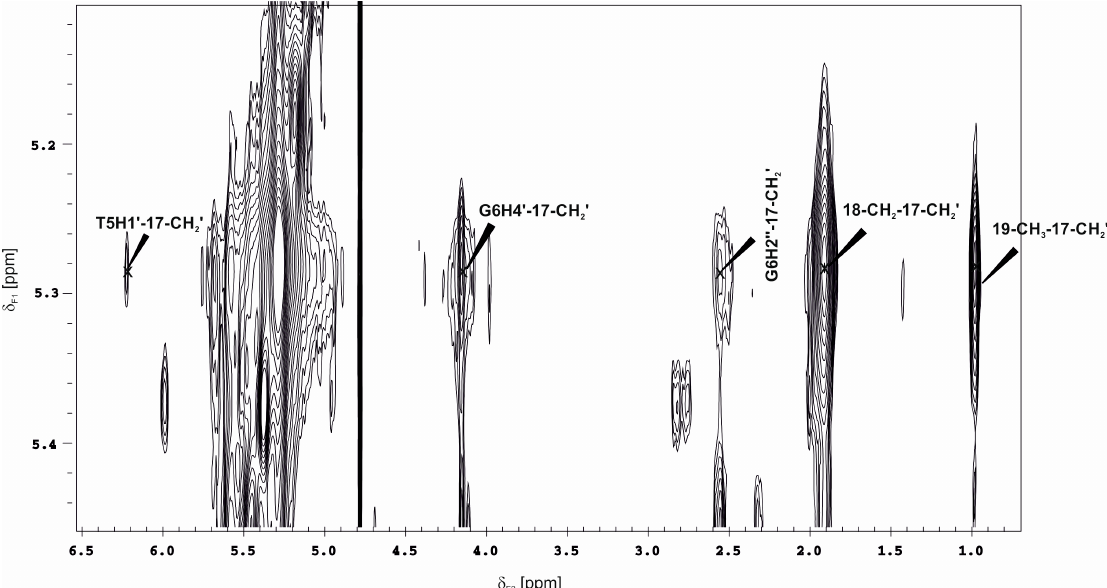
Figure 3. Part of the NOESY spectrum represents the intermolecular cross-peaks between the 17-CH 2 group in compound 1 and DNA bases in the nick of 2B